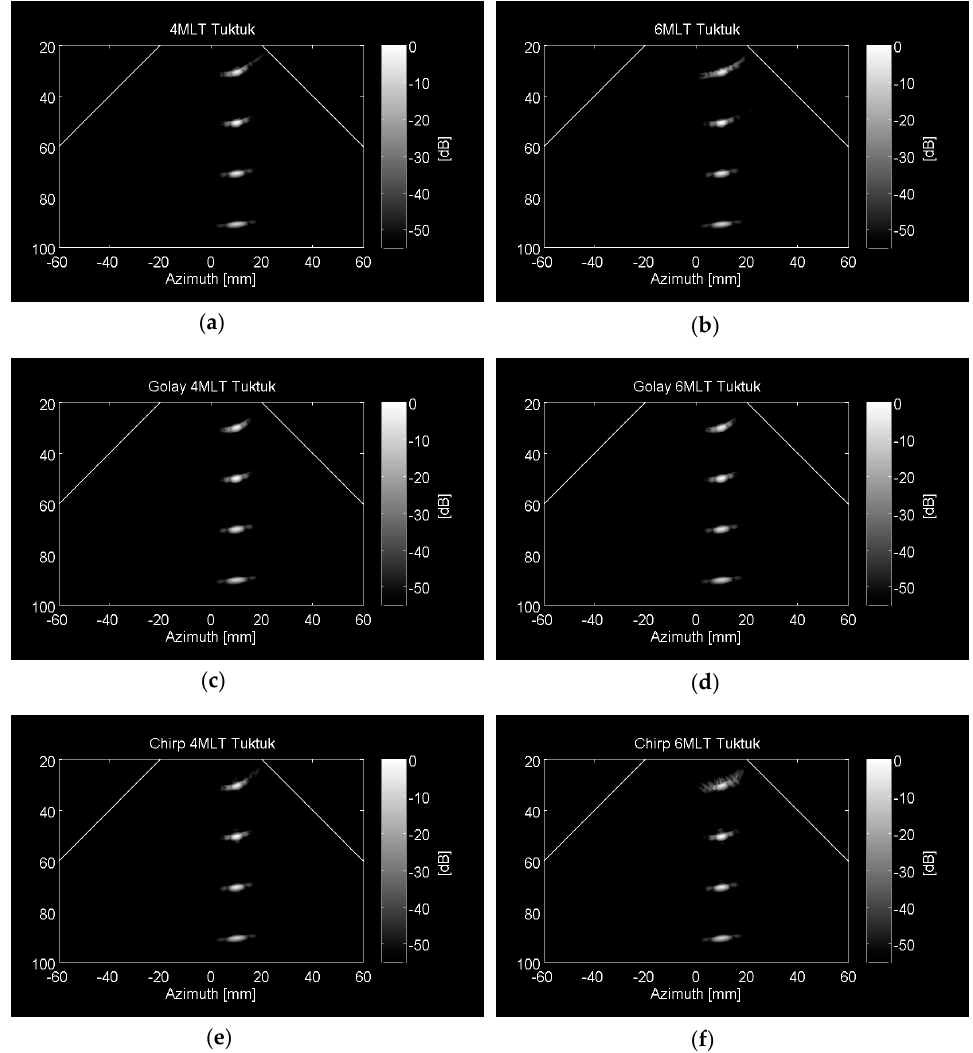
Figure 8. Point-spread-function (PSF) of 4MLT and 6MLT schemes using ( a , b ) non-coded excitation; ( c , d ) Golay coded excitations; and ( e , f ) chirp coded excitations. Tukey ( α = 0.5)-Tukey ( α = 0.5) apodization scheme was applied on transmit and receive that the crosstalk artifacts were largely suppressed. Table 1. Quantifications of different Tukey-Tukey apodized multi-line transimt (MLT) schemes.